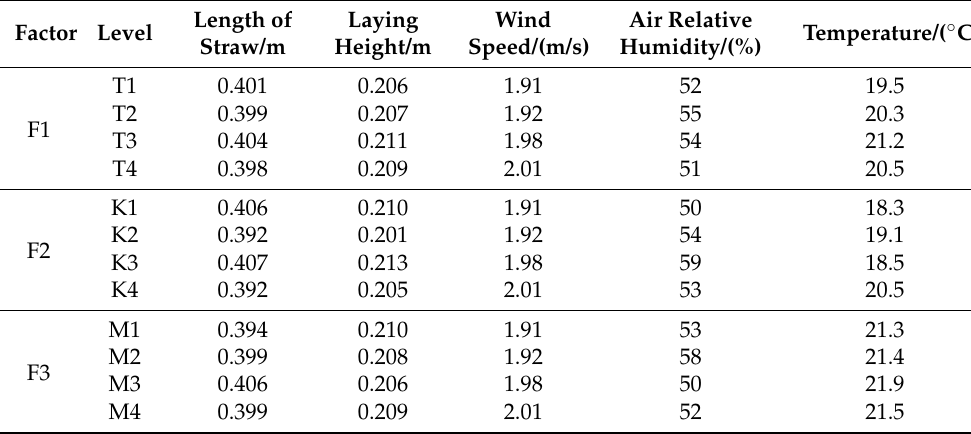
Table 1. Different level settings and corresponding environmental conditions. Length of Factor Level